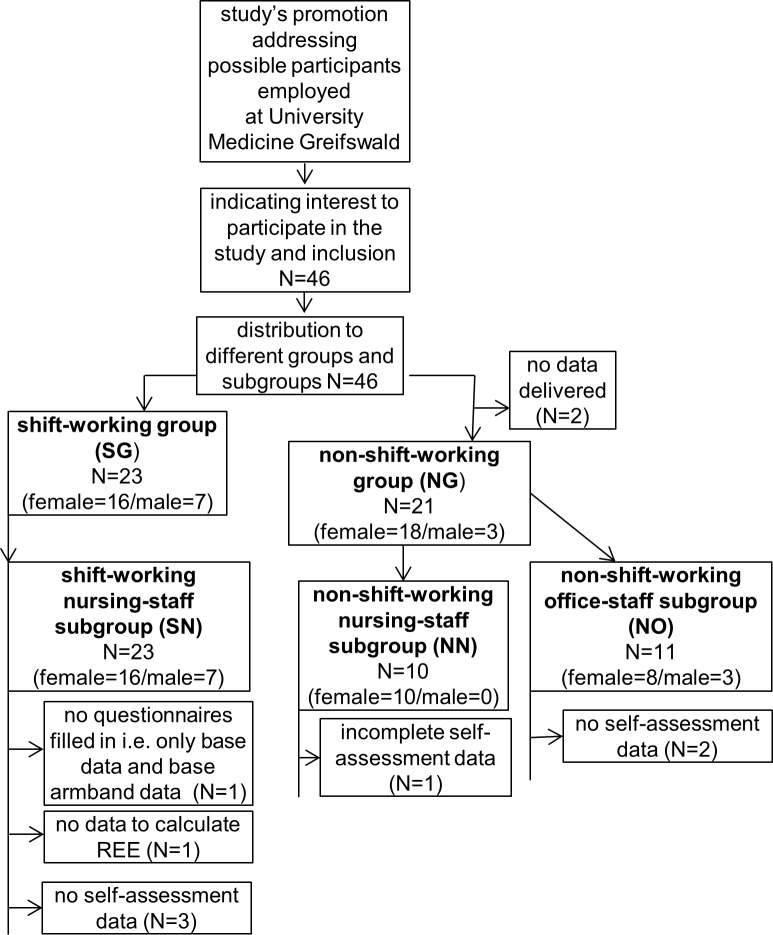
Study’s flowchart for group distribution, group sizes as well as amount of missing data.The shift-working group (SG) only consisted of nursing staff (male and female) from different wards of University Medicine Greifswald. They rotated through day-, evening- and night-shifts. The non-shift-working group (NG) included nurses that worked in outpatient departments, diagnostic units or solely on day-shift on the wards (NN), as well as office administrative staff (NO).